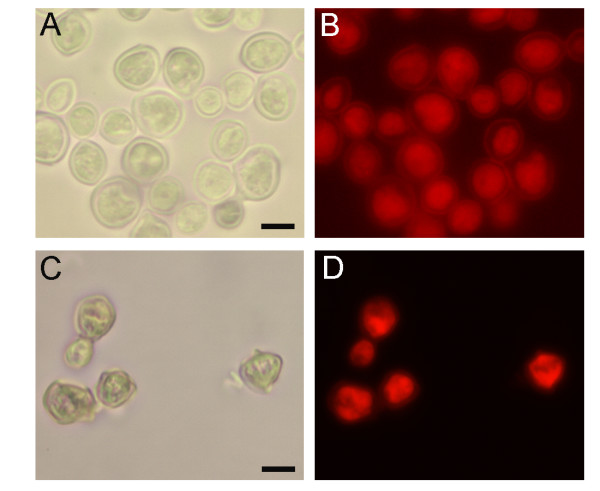
Corresponding light and immunofluorescence microscopy images of W. dermatitidis yeast cells of strain 8656 [A, B] and wdpks1Δ-1 [C, D] grown for 15 days in YPD medium at 37°C that were exposed to liquid nitrogen for 10 minutes prior to incubation with the melanin-binding mAb 6D2. Scale bar, 5 μm.